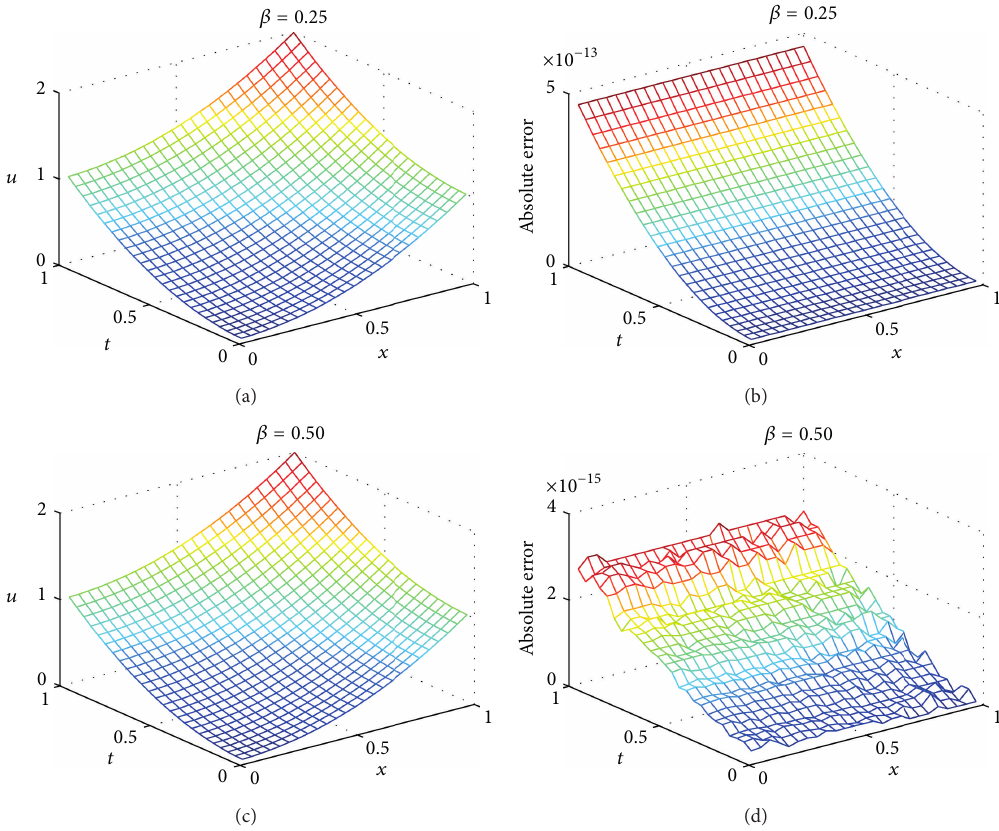
Figure 1: Numerical results for Example 23 when 𝛽 = 0.25,